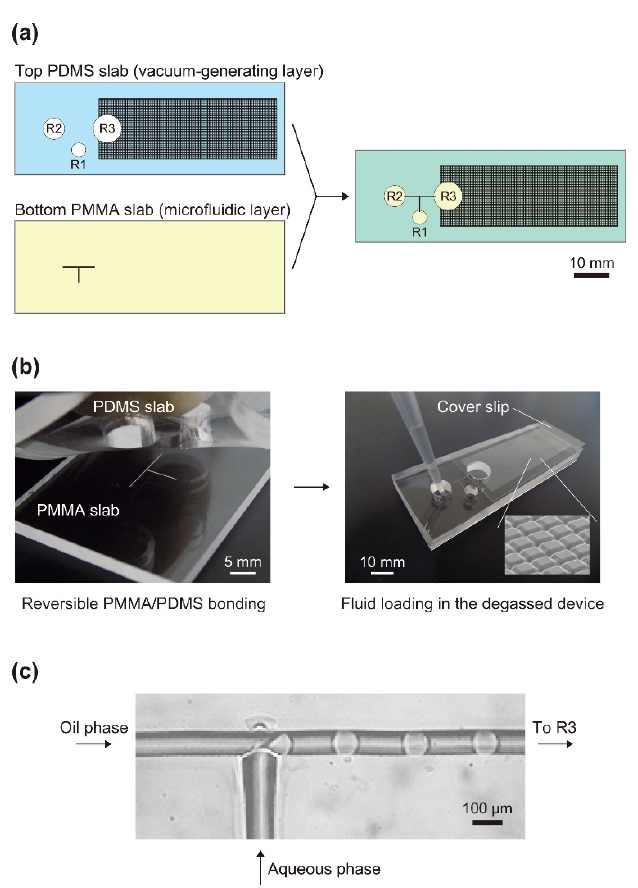
Figure 1. Schematics of the polymer microfluidic chip: ( a ) Drawings showing the chip structure. The shaded rectangular area on the top surface of the top polydimethylsiloxane (PDMS) slab indicates a region of arrayed, orthogonal microgrooves produced through direct-laser patterning. ( b ) Photo- graphs of the chip. Inset: Scanning electron microscopy image of a laser-written microgroove array. ( c ) Optical microscopy image of immiscible flows in a channel in the vicinity of a T-junction.